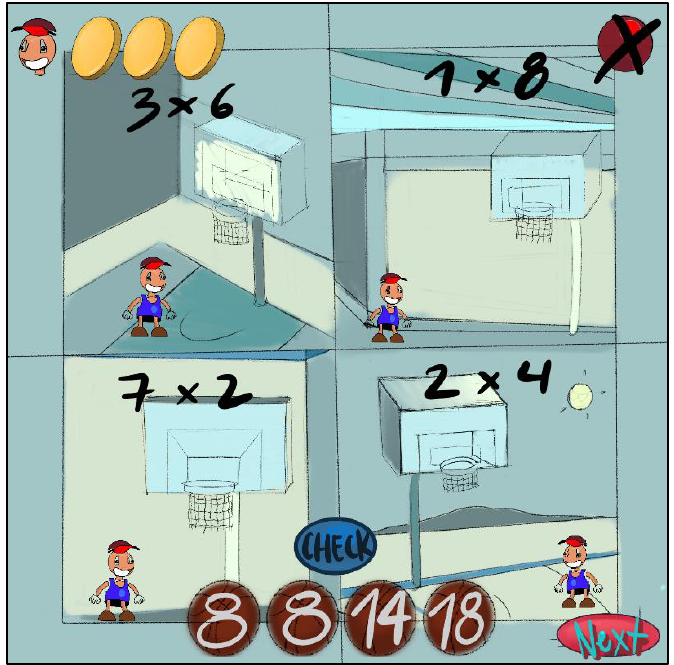
Figure 2. Multiple choice question in second scene. Information 2020 , 11 , 176